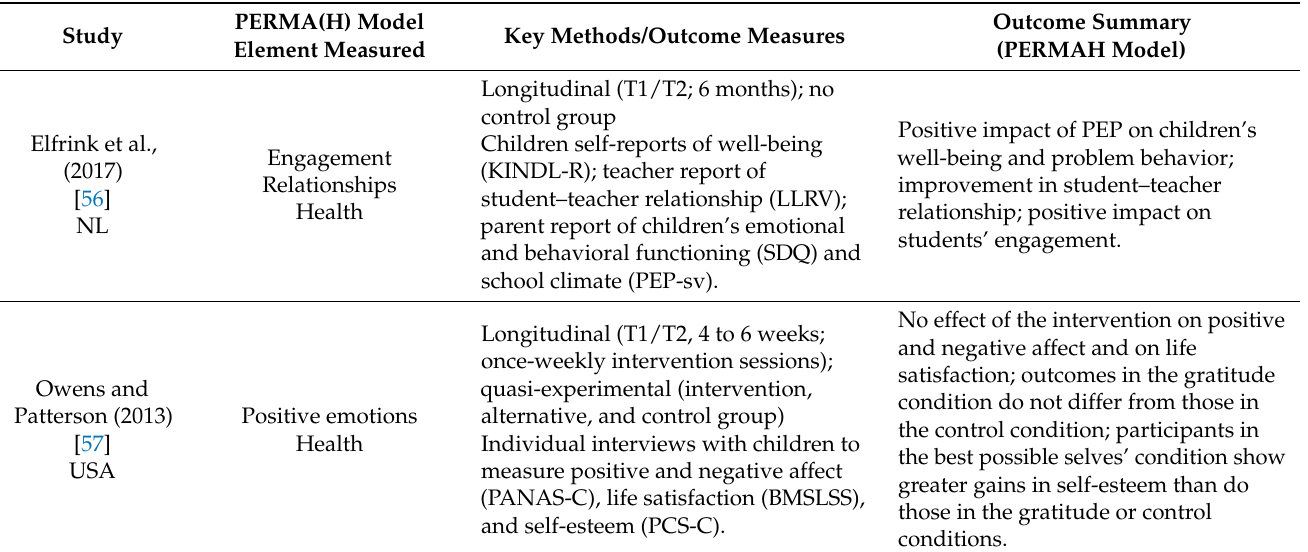
Table 2. Methodological characteristics, measures, and outcome summary of positive psychology interventions on children’s